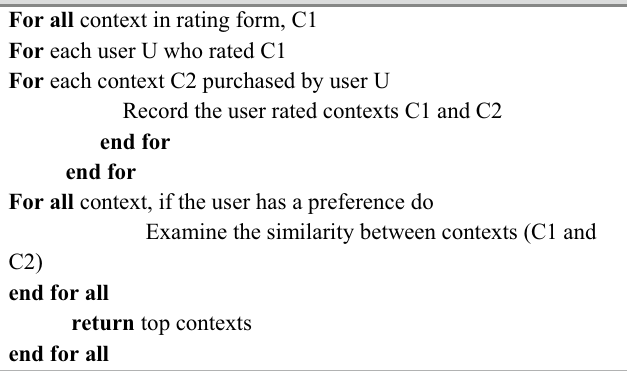
Algorithm 2: Context-Context collaborative